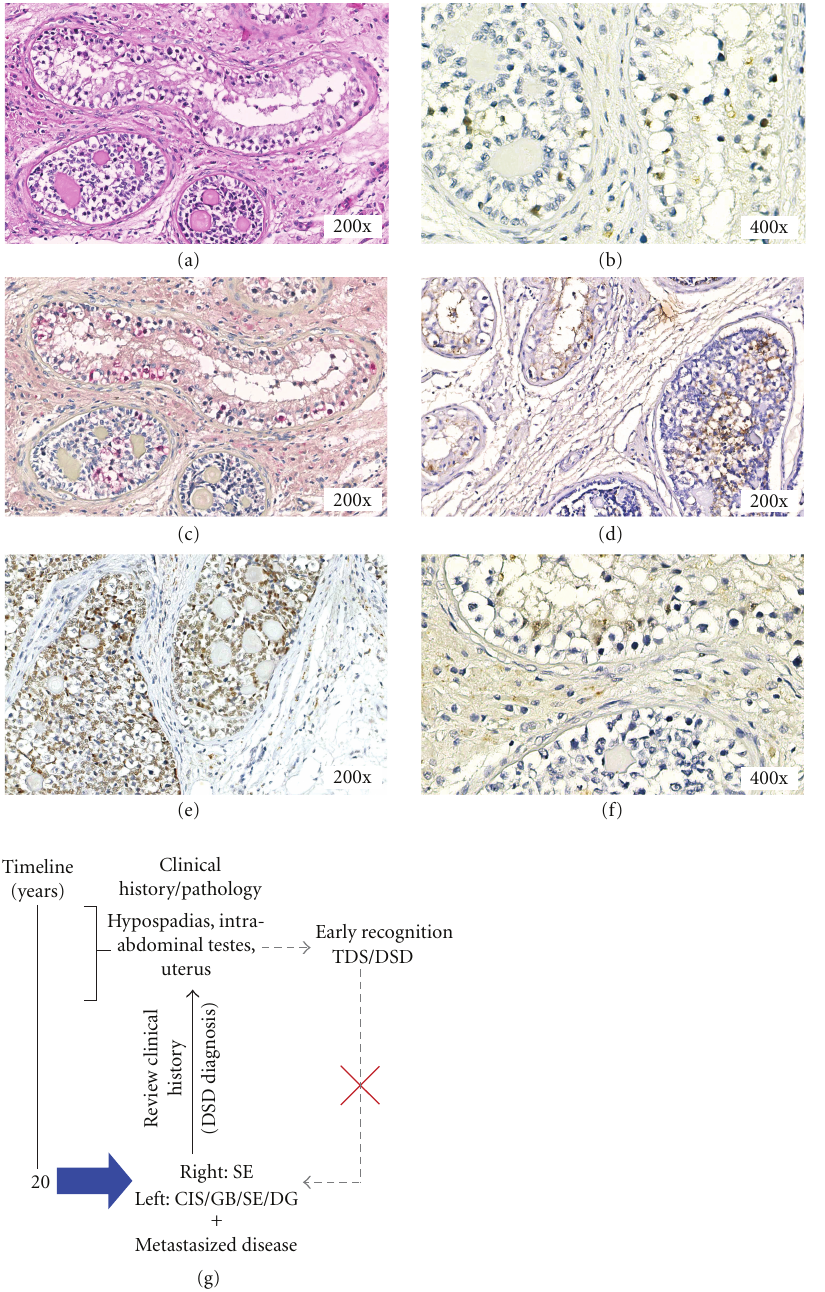
Figure 2: Immunohistochemical staining of the gonadoblastoma and carcinoma in situ lesions of patient 2. (a) Representative hematoxylin and eosin staining. Positive staining for (b) OCT3/4 (brown), (c) TSPY (red), and (d) SCF (brown) of the germ cells present in the GB and CIS. (e) In the GB the supportive cells stain positive for FOXL2 (brown). (f) The supportive cells in the CIS lesion are SOX9 positive (brown staining) and are negative for FOXL2. (a–d), (f) Again, both GB (embryonic germ cells intermixed with granulose-like supportive cells) and CIS (associated with Sertoli cells on the basal membrane of the tubules) are shown. Magnification 200x and 400x for all. Slides (b)–(f) are counterstained with hematoxylin. (g) Timeline showing the clinical history, histology, and actions